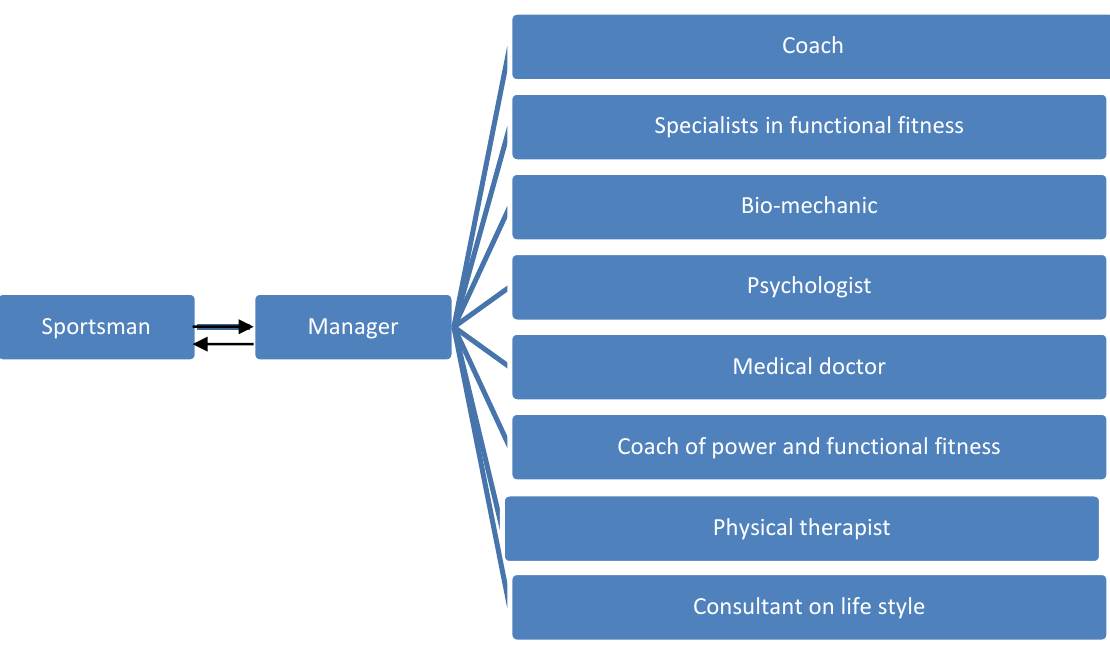
Fig2. Training system, controlled by manager (Abraham, Collins, 2011)